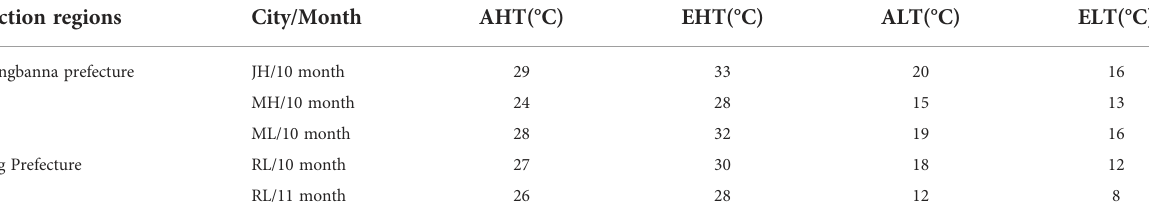
TABLE 1 Temperature of sampling areas in Yunnan Province,